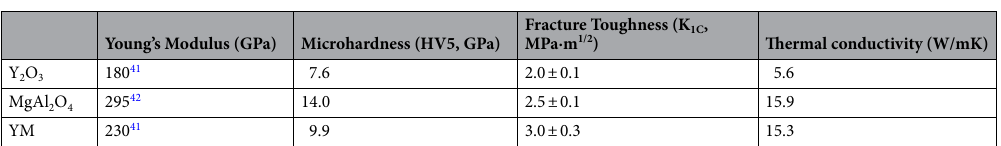
Table 2. Mechanical and thermal properties of